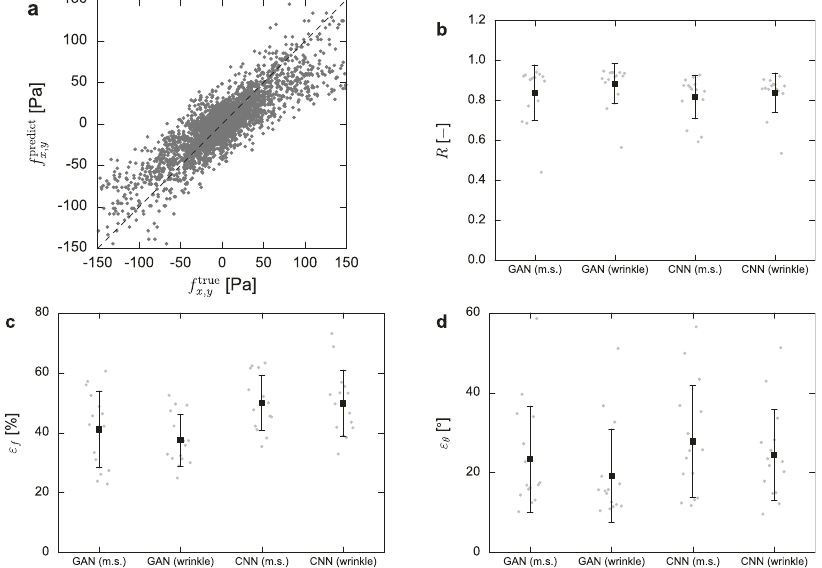
Fig. 6 Quanti fi cation of the errors in prediction. a Comparison of the ground truth f true x ; y and the predicted traction f predict x ; y . Dashed line shows a condition f predict = f true . Note that we randomly reduced the number of data point 1/5 for the visibility. b Correlation coef fi cient R between f true the predicted traction compared to the ground truth data: c error in the traction magnitude ε f and d the traction direction ε θ . Note that bars show average errors±standard deviations among the sample number n = 15, and gray dots indicate the original data. The description m.s. denotes the microscope images.